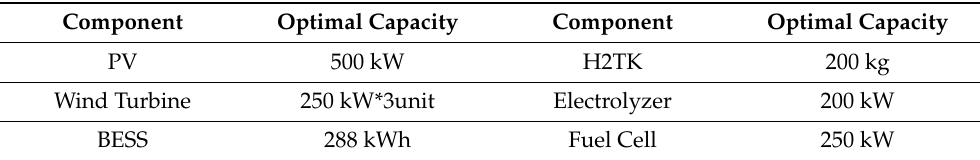
Table 12. Microgrid composition of S3.